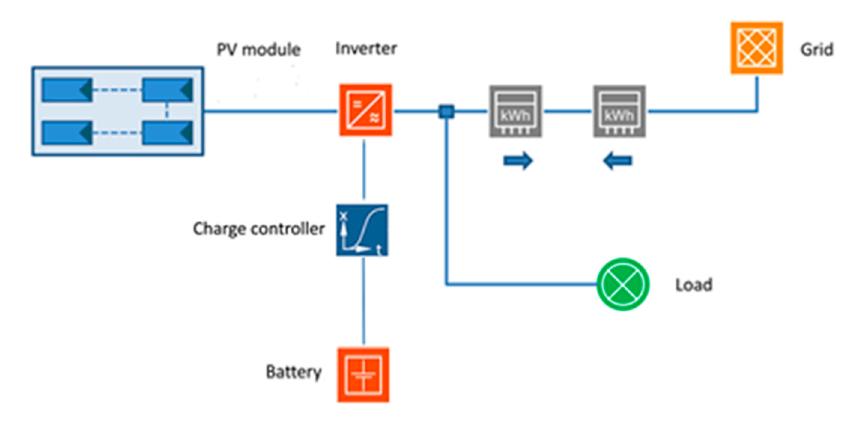
Figure 5. Schematic representation of the storage on the grid PV system.